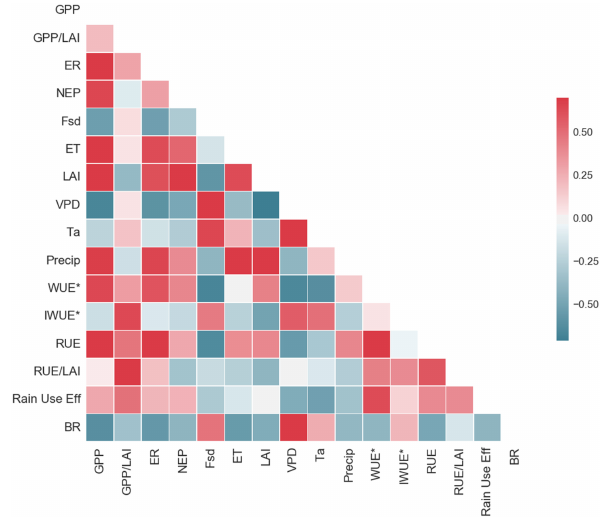
Figure 5. Simple heat map of Australian OzFlux tower measure- ments to identify the correlations between fluxes, driving variables, and ecosystem indices using all site-averaged data for available site years to represent spatial variability. Fluxes are gross primary pro- ductivity (GPP), ecosystem respiration (ER), net ecosystem pro- duction (NEP), and evapotranspiration (ET). Drivers are leaf area index (LAI), precipitation (Precip), air temperature ( T a ) , incoming solar radiation ( F sd ) , and vapour pressure deficit (VPD). We used the following ecosystem indices: radiation-use efficiency (RUE) following Garbulsky et al. (2010); ecosystem water-use efficiency (WUE ∗ ), and inherent ecosystem WUE ∗ (IWUE ∗ ) following Beer et al. (2009); the Bowen ratio (BR) is defined as the ratio between sensible and latent heat fluxes (Bowen, 1926); leaf area index (LAI) was obtained from the average of the MODIS MOD15 product for the site years available that has been de-spiked using the procedure described in Kanniah et al. (2009a); and rainfall-use efficiency was defined following Huxman et al. (2004) as the ratio of GPP to pre- cipitation. GPP and RUE are also normalized by LAI by dividing them by LAI to produce series such as GPP/LAI. The colour scale indicates the strength of the Pearson correlation co-efficient ( r